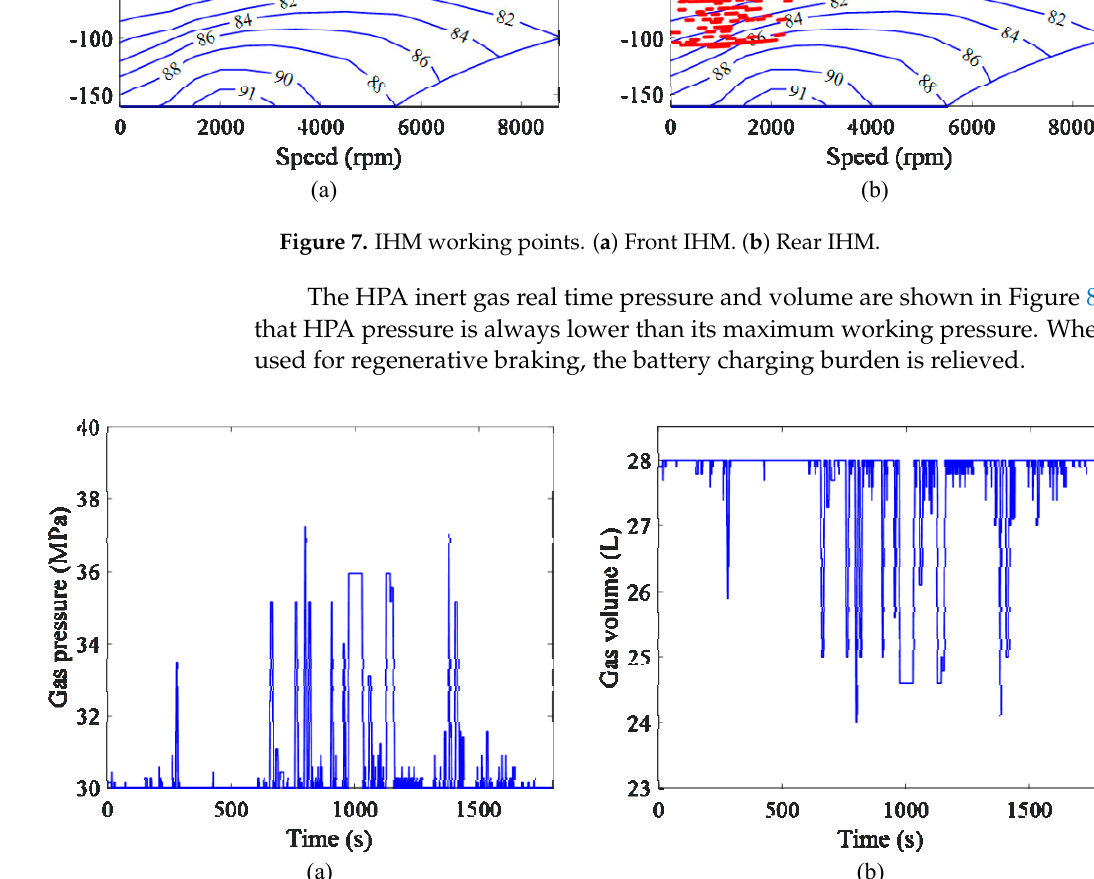
(b) Figure 9. CEM and CHM working points in IHV. ( a ) CEM. ( b ) CHM. 5.4. Energy Consumption Comparison The energy consumption and SoC of each vehicle is shown in Figure 10 and listed in Table 4. It could be found that the IEV consumes slightly more energy than the CEV. The main reason is that the IEM has lower efficiency than the CEM, especially at a low speed area. These results indicate that although the driveline is simplified in IEV, which helps reduce power loss, the lower IEM efficiency makes the IEV not very competitive on the energy economy. However, as mentioned above, the advantage of the IEV is in improving the vehicle stability and handling performance by torque vector control. The energy consumption of IHV is 40% more than the CEV and 34% more than the IEV, which demonstrates a bad energy economy of the IHV. The reason for this is that the hydraulic